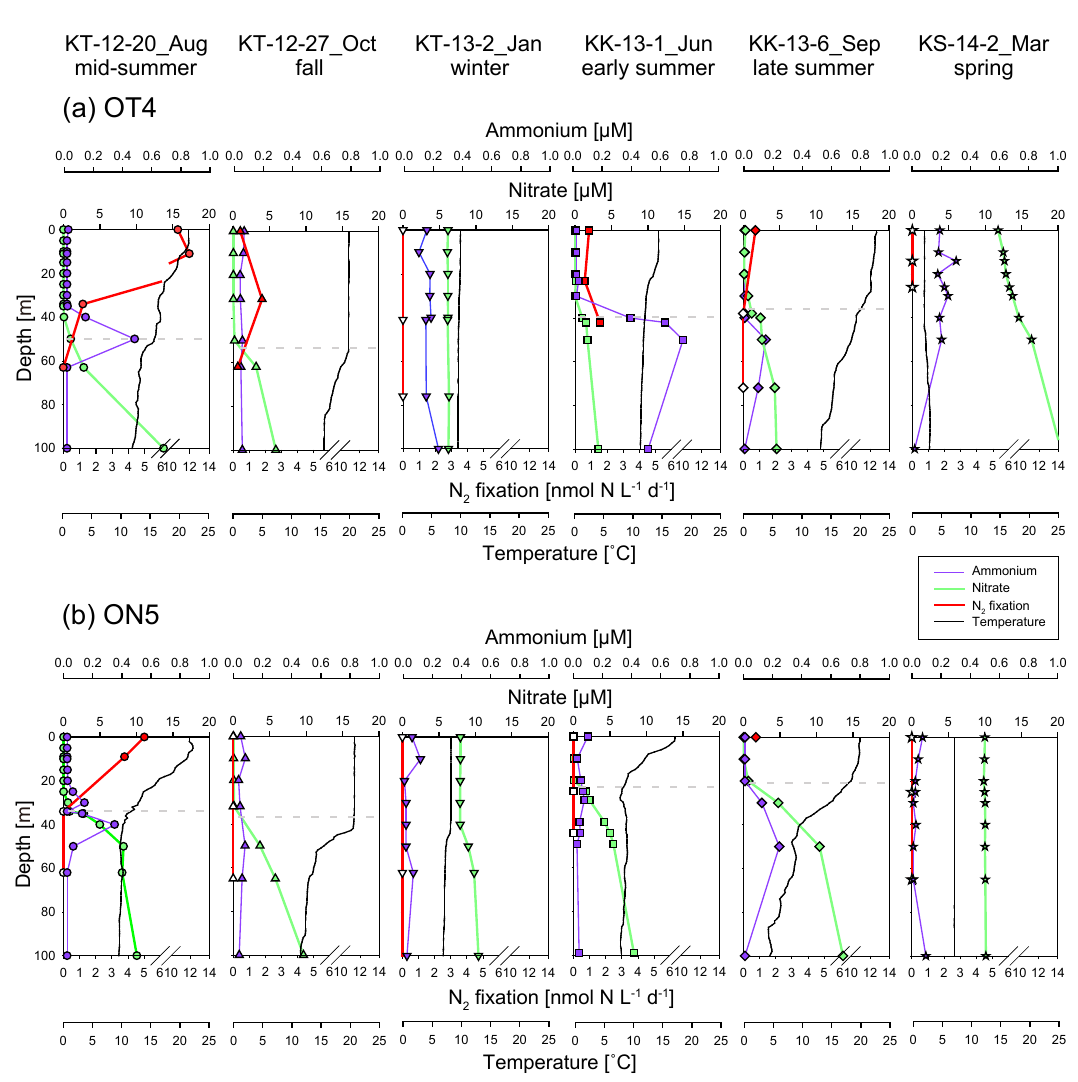
Figure 5. Time-series variations in the vertical profiles of temperature [ ◦ C] (black), ammonium (purple) and nitrate (green) concentration [µM], and nitrogen fixation (red) [nmolNL − 1 d − 1 ] at Stns (a) OT4 and (b) ON5. Open symbols indicate that nitrogen fixation was not detected. The horizontal dashed line indicates the nitracline depth. The strait lines of temperature and nitrate were ascribable to strong mixing.